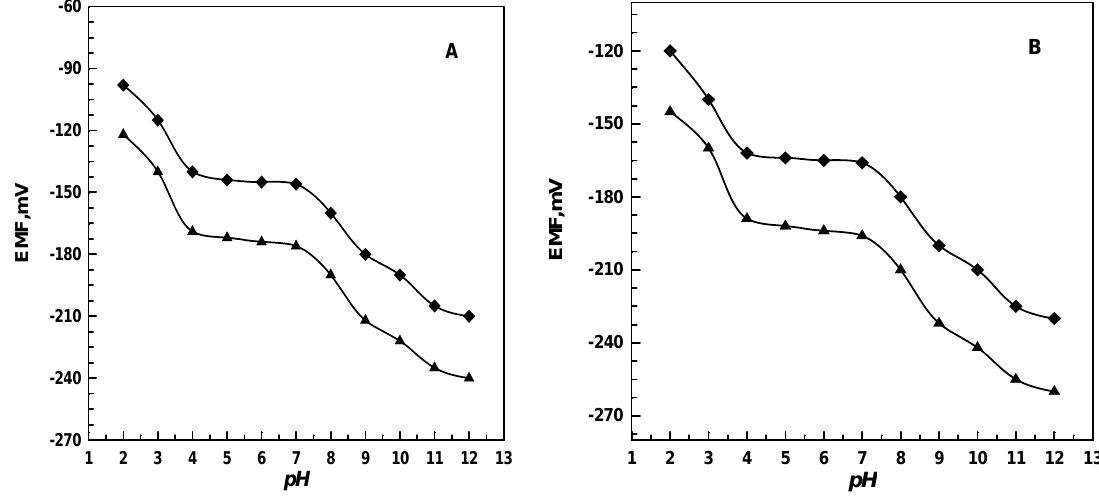
Figure 2. Effect of the pH on the potential responses of; (A) (PT) sensor with additive and (B) (TP) sensor with additive at ( ♦ ) 1.0×10 -2 M and ( ▲ ) 1.0×10 -3 M lead